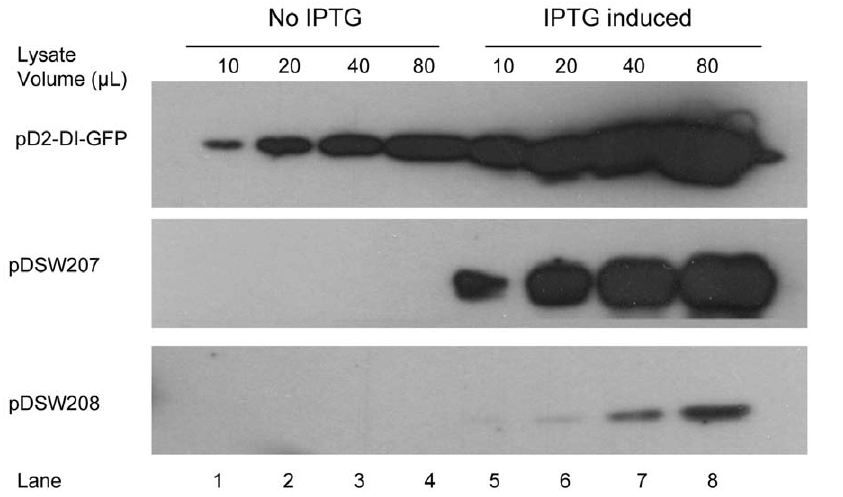
Figure 4. The efficiency of the DENV cDNA cryptic bacterial promoter. E coli cells transformed with pD2-GFP, pDSW207 or pDSW208 were cultured at 37 u C for 5h in the absence (lanes 1–4) or presence (lanes 5–8) of IPTG. The numbers of bacterial cells in each culture were normalized, and the cells were pelleted by centrifugation before lysis. Proteins were resolved by SDS-PAGE and analysed by Western blot employing anti-GFP antibodies. The volume of clarified lysate loaded into each lane is shown.